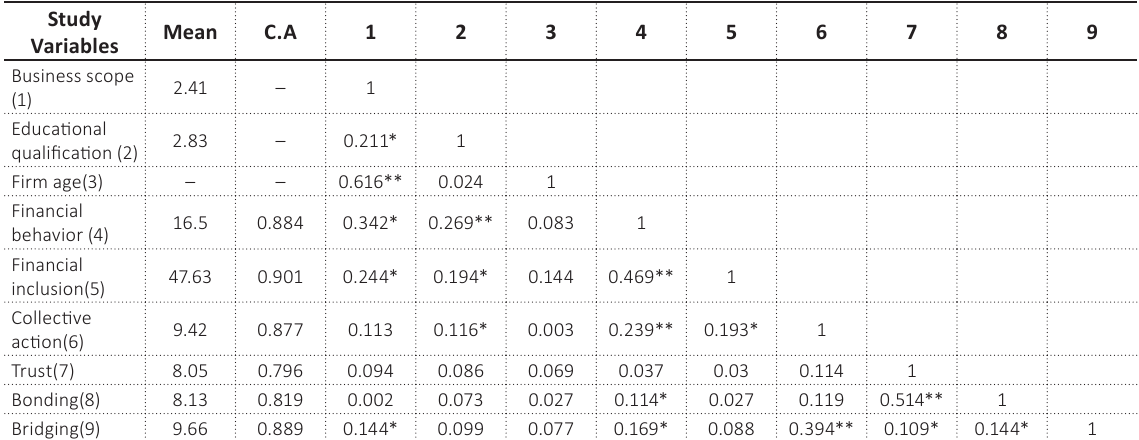
Table 1. Means, Cronbach’s alpha, and zero-order